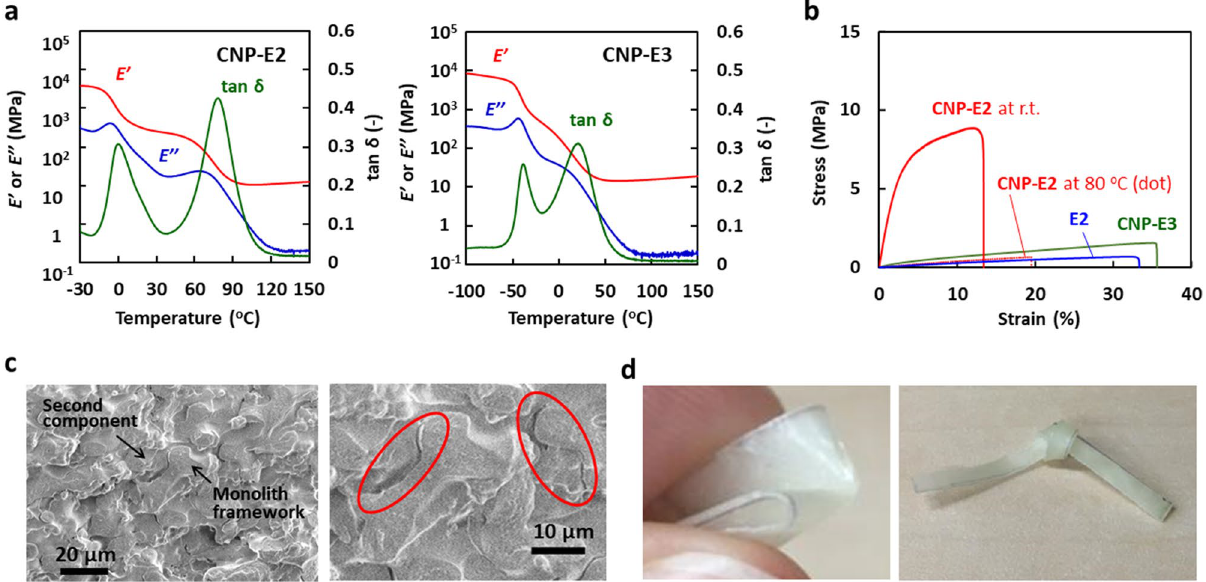
Figure 3. Thermal and mechanical properties of the CNPs filled with soft epoxy resin. ( a ) Temperature dependence of E’ and tanδ for CNP-E2 and CNP-E3 determined by DMA at a frequency of 1 Hz and the heating rate of 2 °C/min. ( b ) Stress–strain curves of CNP-E2 measured at room temperature and 80 °C, CNP-E3 at room temperature, and the bulk thermoset of E2 at room temperature. ( c ) SEM image of the fracture surface of CNP-E2 after the tensile test. Some gaps are detected at the interface of the two components. The right image is expanded and red ellipsoids indicate the formation of large gaps between the first and second components. In these SEM images, each co-continuous domain of the two different epoxies is distinctly observed. Smaller pores with a size less than a micrometer are seen in the monolith skeleton, being formed by a secondary phase separation during the first fabrication process of the epoxy monolith (see also ref. 30). ( d ) Photographs of the folded and tied CNP-E2. For the fabrication of the CNPs filled with epoxy resins, M120A was used as the monolith